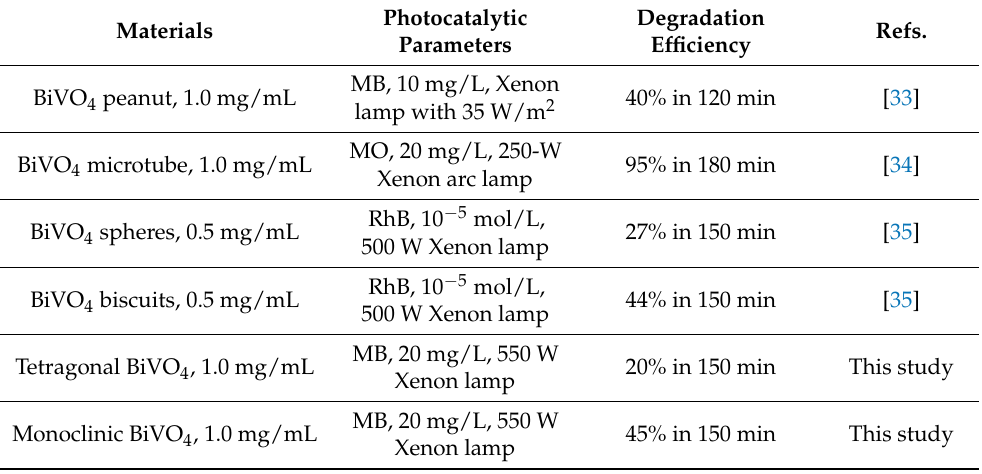
Figure 8. Degradation curves of the methylene blue solution under the different BiVO 4 degradation conditions. Table 3. Photocatalytic activity of BiVO 4 toward different dyes under visible light